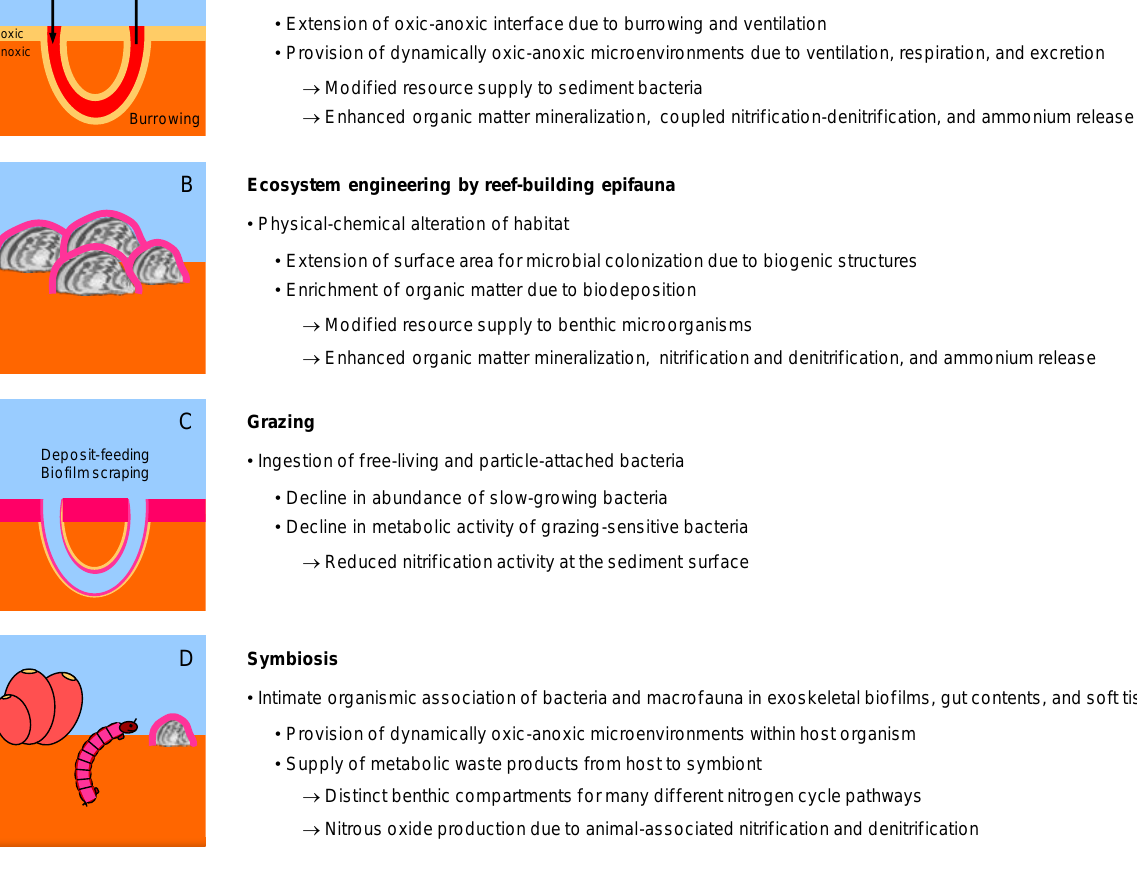
Fig. 2. Three types of animal–microbe interactions that interfere with benthic nitrogen cycling in aquatic ecosystems: (A) and (B) ecosystem engineering, (C) grazing, and (D) symbiosis. The site of the microbial activity of interest is highlighted in pink (A) : sediment burrow, (B) : surface of biogenic reef structures, (C) : sediment surface and burrow wall, (D) : soft tissues, gut, and shell biofilm. Drawings of animals and biogenic structures are stylized and not to